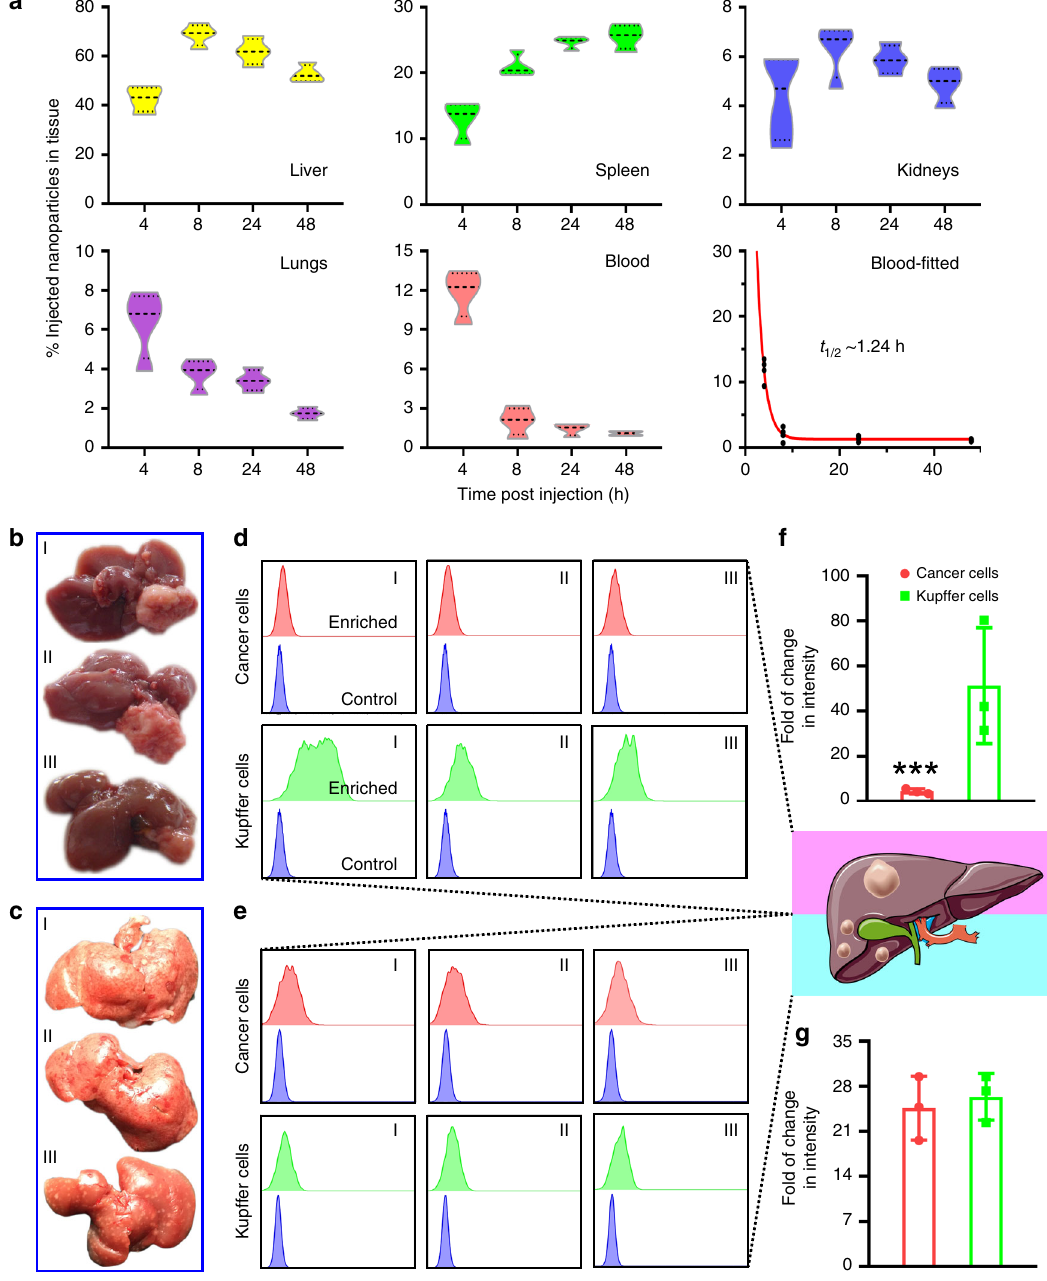
Fig. 5 Pharmacokinetic analysis. a The bio-distribution pro fi les of Mito(T)-pep-Nuc(T). Mice bearing DLM were injected intravenously with Mito(T)-pep- Nuc(T) before sacri fi ced at different time points. Four organs including liver, spleen, kidneys, and lungs were collected in addition to blood sample. The violin plot outlines illustrate kernel probablity density, with the area revealing the population of located data. Data are presented as mean ± s.e.m. ( n = 3). b , c Necropsy images of liver tissues bearing b HCC and c DLM. These tissues were sampled as I to III, followed by processing and analyses individually. d , e shows the fl ow-cytometry results of cancer cells and Kupffer cells enriched from the single cell suspension produced from d HCC and e DLM. In each graph, the upper row displays the histogram of enriched cells, with the lower row lays the same control cells received no treatment. A cartoon was given right to d and e , wherein the simpli fi ed pathological features of HCC and DLM were shown. f , g The averaged results of fl uorescence intensity change (Ce6) in a fold of change fashion for f HCC and g DLM model, respectively. Data are presented as mean ± s.e.m. ( n = 3). P values were calculated by Student ’ s t- test (*** p <